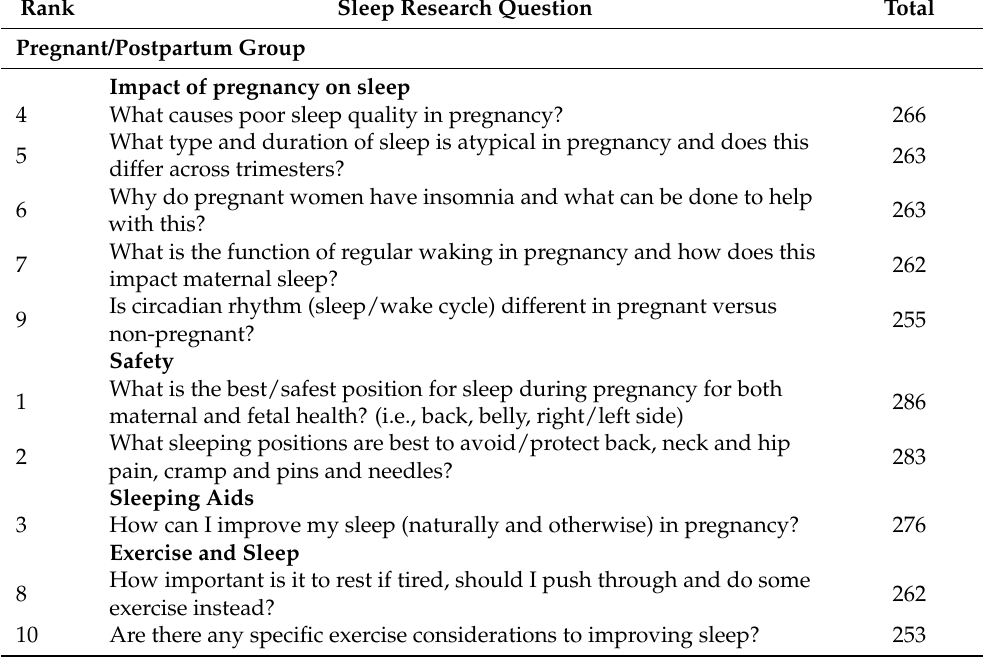
Table 3. Top 10 sleep research priorities by theme according to pregnant/postpartum women (for full overall league table, see Supplemental Digital Content